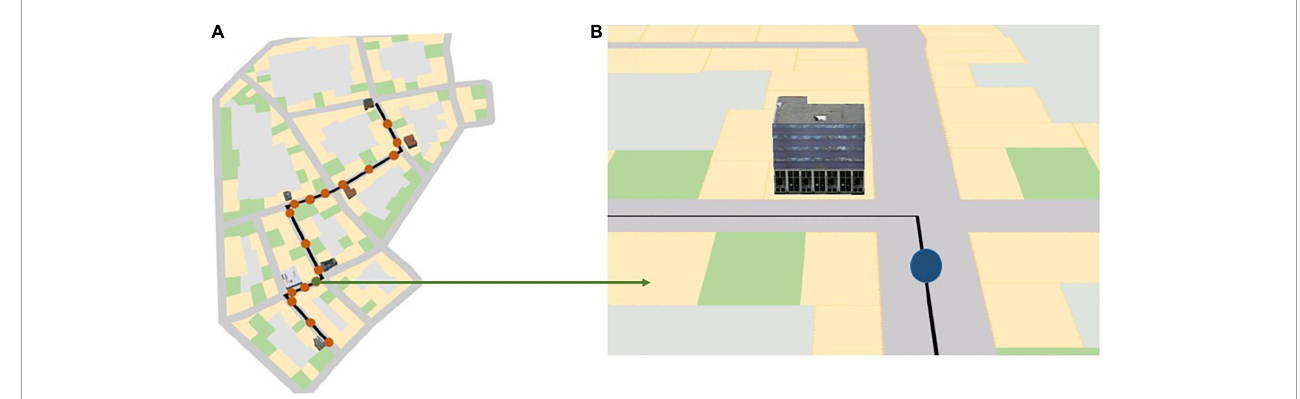
FIGURE2 (A) Red dots along the black navigation route indicate the 17 map pop-up spots during navigation in the three different landmark conditions; (B) a mobile map that rotates along with the participant’s head direction, as seen by the participant at the location of the green dot in panel (A) . The blue dot in panel (B) indicates the participant’s current location in the virtual city. The black line indicates the path the participant needs to follow. Depending on the landmark condition, three, five, or seven 3D landmarks are shown on the map at a turning intersection. The figure is adapted from Cheng et al. (2022b).